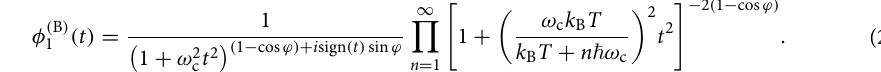
2 π/ 4 ) and middle = π is positive. =